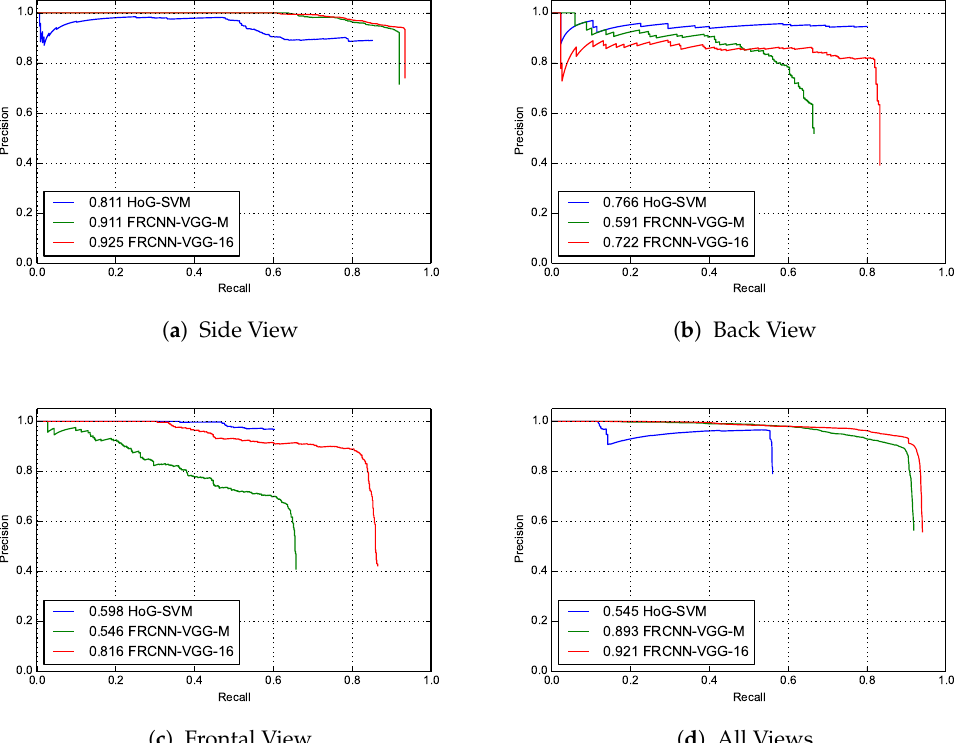
Figure 4. Precision–recall curves of three different object detection techniques for the kangaroo detection task over four subsets of the generated synthetic testing dataset. The score of average precision (AP) is listed before the name of each technique. The subsets are categorized according to three individual orientations of the kangaroos in the testing scenes from the range sensor’s point of view. ( a ) side view, ( b ) back view, ( c ) frontal view. Additionally, the combination of all these scenarios ( d ) all